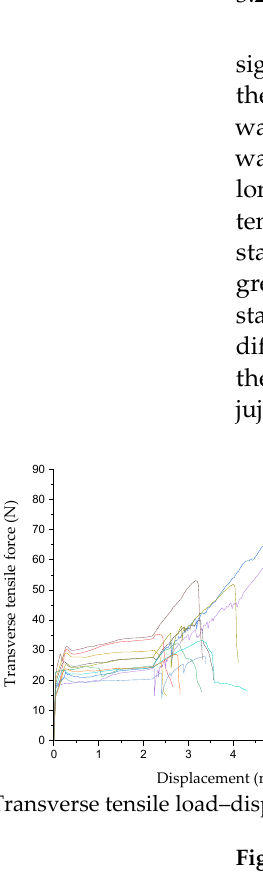
Figure 6. Boxplot and fitting function of longitudinal maximum tensile force.